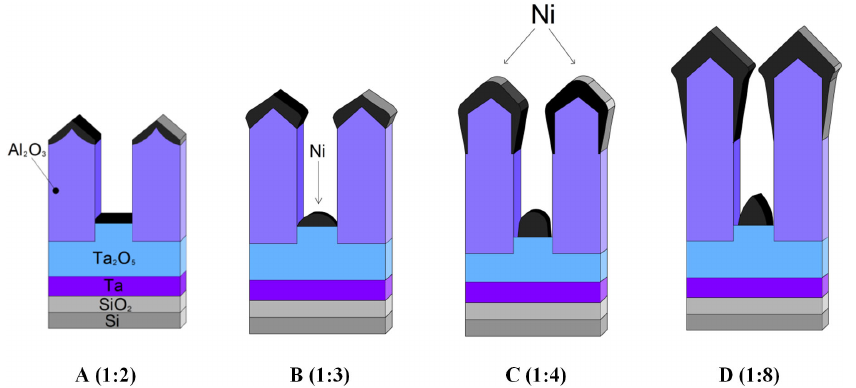
Figure 1. Schematic representation of possible shadowing effects of the Ni coating deposited onto a thin porous anodic film. The thickness of the Ni coating increases and the ratio of the pore diameter to the oxide thickness decreases from ( A – D ) [50].